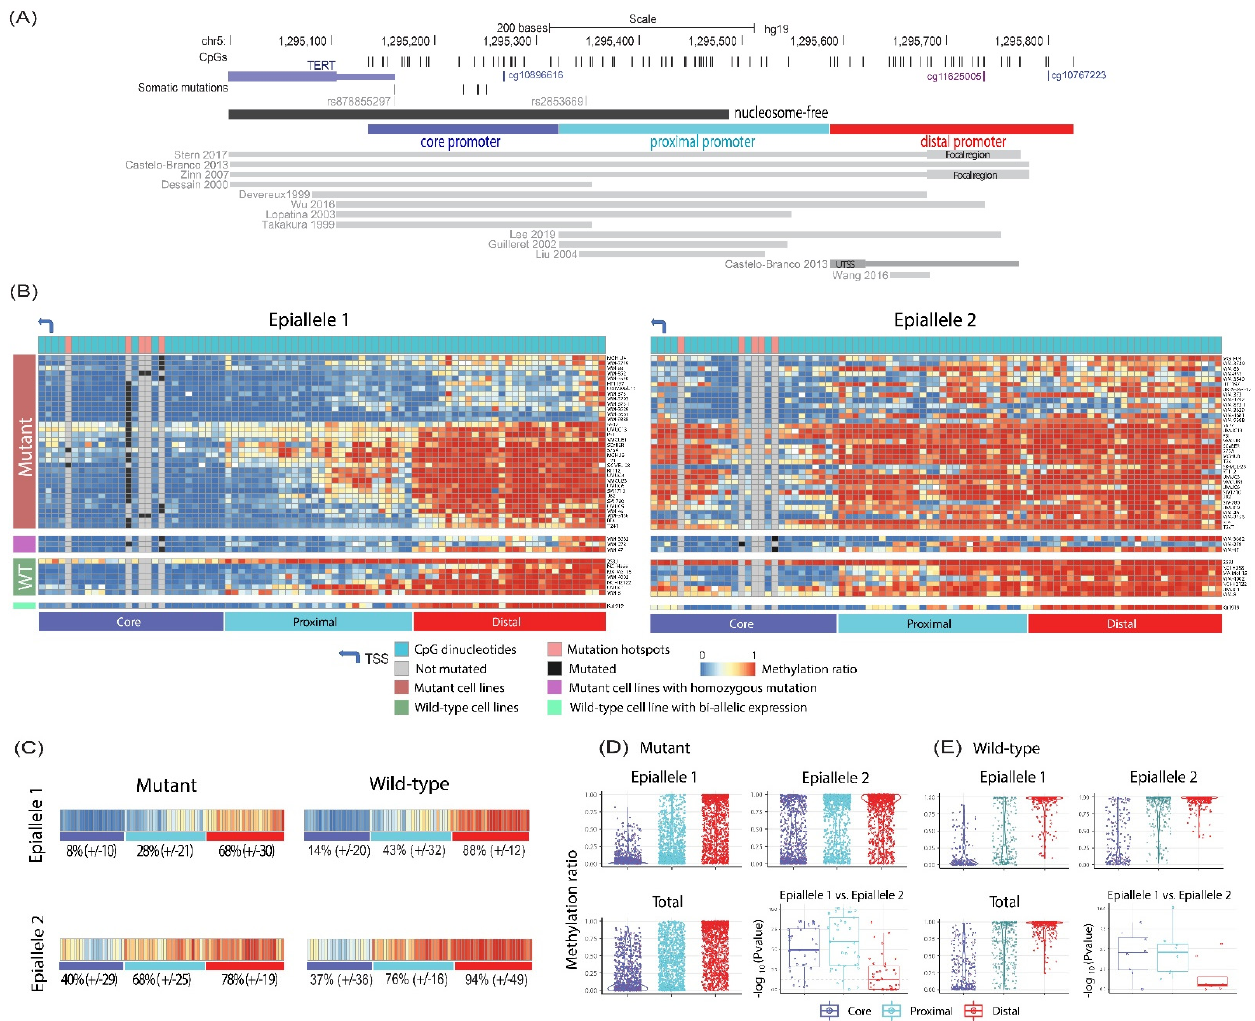
Figure 2. Allelic methylation levels in TERT promoter mutant and wild-type cancer cell lines. ( A ) TERT promoter map shows CpG dinucleotides, somatic point mutations, and SNPs in the 763 bp region (chr5:1,295,104–1,295,866, hg19). The start codon is located at chr5:1,295,104. Based on meth- ylation profiles, three promoter regions were defined in this study: the core promoter ((187 bp, chr5:1,295,135–1,295,321), encompassing the recurrent promoter mutation sites), the proximal pro- moter (264 bp, chr5: 1,295,322–1,295,585), and the frequently methylated distal promoter region (239 bp, chr5: 1,295,586–1,295,824). The previously studied regions are denoted by the publication [20,24,28,35–43] (Supplemental Table S6). The thicker bars represent focal regions interrogated in a greater depth in those studies. ( B ) Methylation levels per CpG dinucleotides per epiallele in the TERT promoter. Epialleles of the TERT promoter were determined by iteratively clustering the CpG methylation patterns of the reads generated from high-throughput sequencing of bisulfite con- verted DNA amplification. Only the cell lines with two putative epialleles are shown (wild–type cell line n = 8; mutant cell line n = 37). ( C ) Averaged epiallele CpG methylation level in wild–type and mutant cell line reads. Average methylation values (+/ − standard deviation) in the core, proximal, and distal promoter regions are indicated. ( D ) Distribution of the methylation ratio in the TERT core, the proximal, and the distal promoter regions is shown for epialleles in mutant cell lines. Each dot represents a CpG site in a cell line. In most of the examined cell lines, epiallele 2 has a signifi- cantly higher methylation ratio than epiallele 1 in both the core (85%, n = 29) and the proximal pro- moter (91%, n = 31) ( p < 0.05, one–tail Wilcoxon rank sum test). ( E ) CpG methylation ratios were determined in wild-type cell lines as described for panel D. In all examined wild-type cell lines, except for bi-allelically expressing Ku1919 cell line ( n = 7), epiallele 2 has a significantly higher